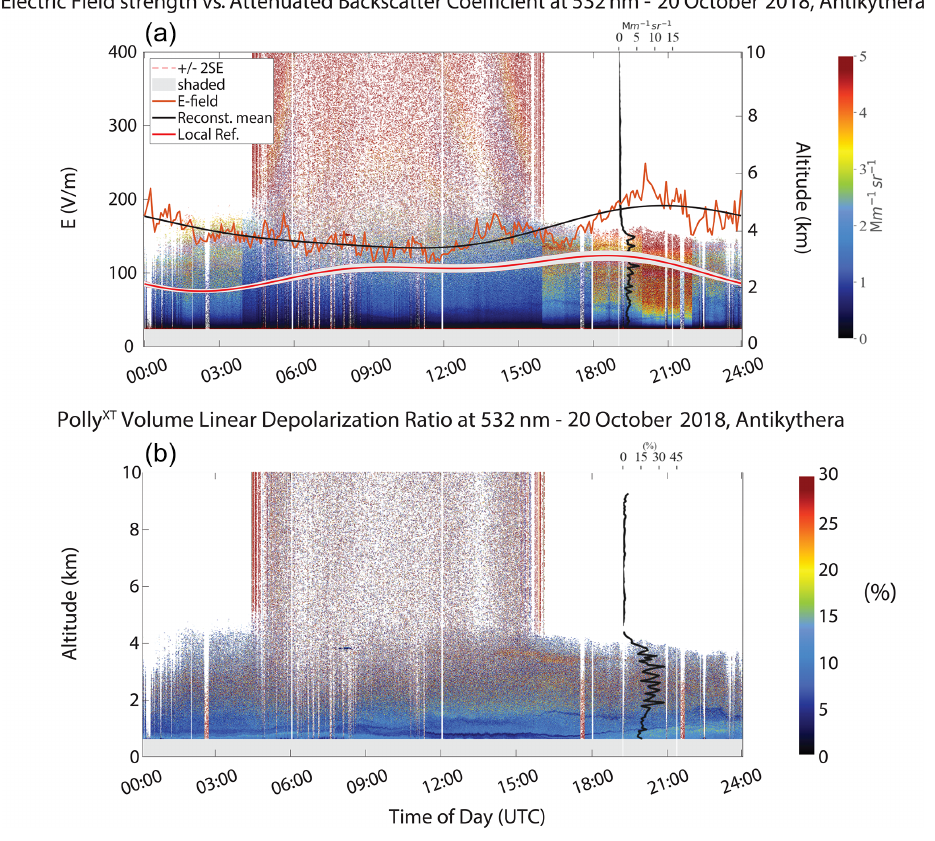
Figure 7. (a) Time series of the vertical electric field strength (orange), the extracted localized reference (ref.) electric field (red) and the reconstructed (reconstr.) mean electric field variation (black) from the field mill dataset, for the recorded 20 October 2018 dust layer at Antikythera. The E-field data are plotted with the time–height evolution of the attenuated backscatter coefficient (Mm − 1 sr − 1 ) and the particle backscatter coefficient ( β ) profile (Mm − 1 sr − 1 , black vertical line) at 532nm from the Polly XT lidar, which was co-located with the field mill. Areas of increased particle concentration are denoted with red tones, while the β values are derived by averaging between 18:00 and 21:00UTC. (b) Volume linear depolarization ratio ( δ v , %) at 532nm for the same dust layer as obtained from the Polly XT lidar and the particle linear depolarization ratio ( δ p , %) profile (black vertical line), again averaged between 18:00 and 21:00UTC. Large δ v values are depicted with red